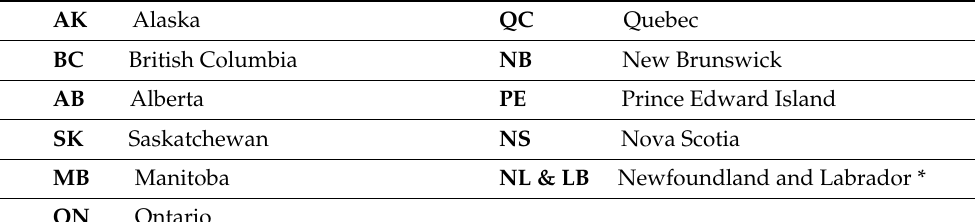
Table 1. Abbreviations of provinces used in the